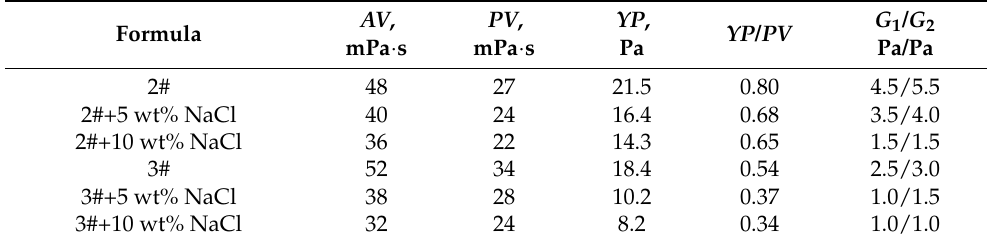
Table 4. Influence of salt concentration on rheological behavior of bentonite-free drilling